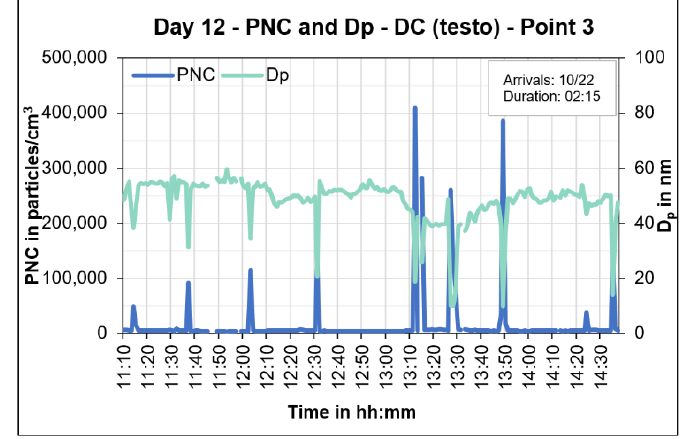
Figure 13. Day 12 PNC and D p results.